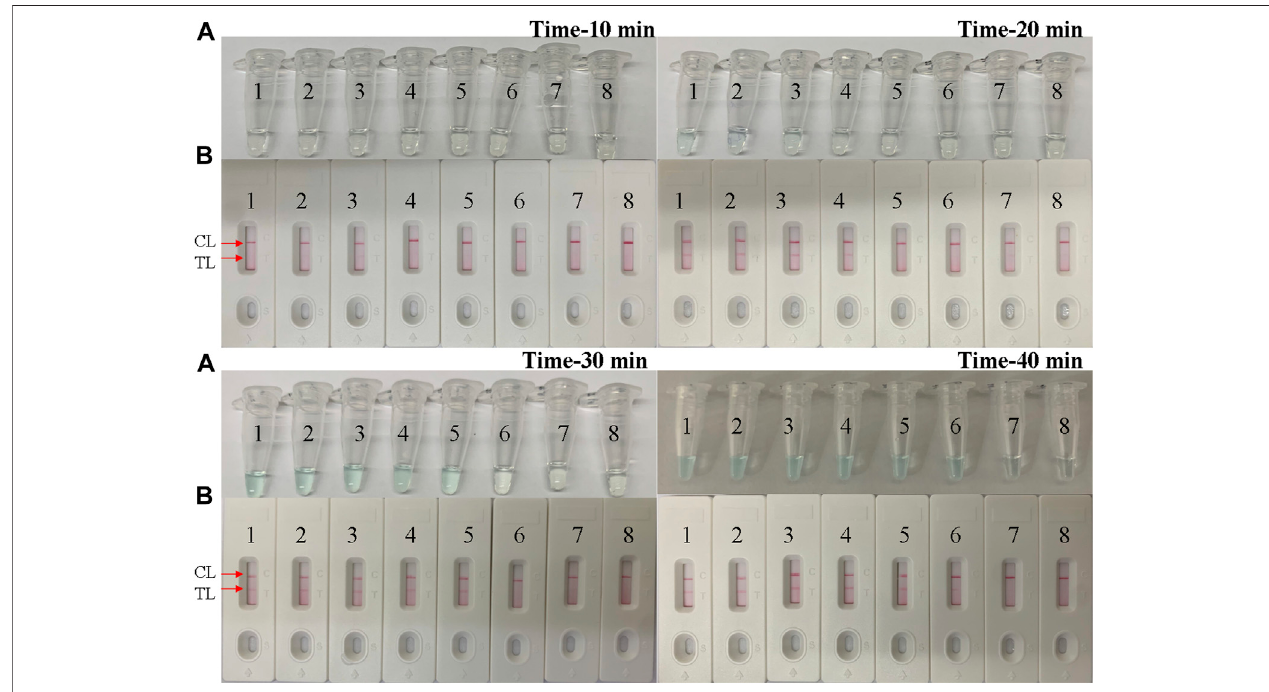
FIGURE 5 | Optimal time for the Bordetella pertussis loop-mediated isothermal ampli fi cation (LAMP) assay. Tenfold serial dilutions of the B. pertussis templates were used for the optimization of time. The LAMP reactions were conducted at different times from 10 to 40 min, with 10-min intervals. The products were indicated by the visual detection reagent (A) and a nanoparticle-based lateral fl ow biosensor (LFB) test (B) . Tubes/strips 1 – 7 represent serial dilutions of DNA: 5 ng; 500, 50, and 5 pg; and 500, 50, and 5 fg per reaction. Tube/strip 8 represents the blank control. TL , test line; CL , control line.